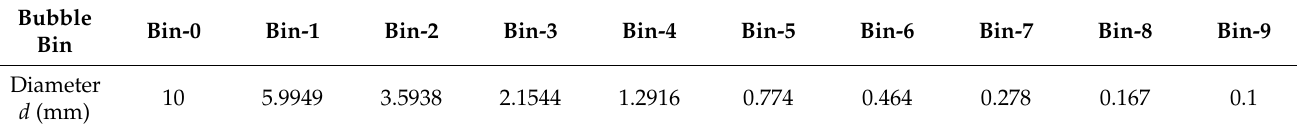
Table 2. Discrete bubble size.